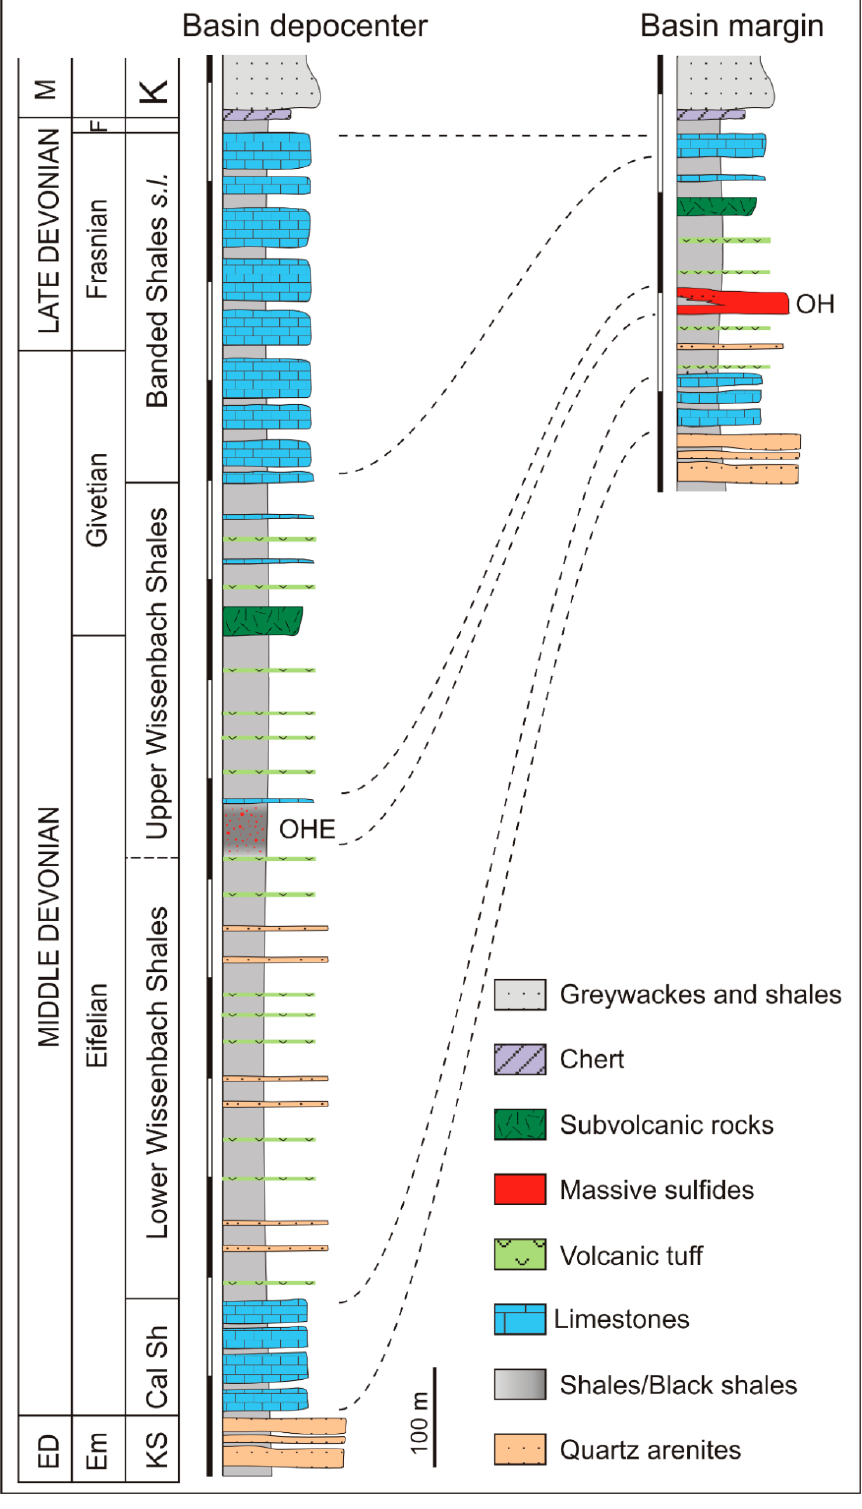
Figure 3. Correlation between the stratigraphic logs at the basin depocenter and basin margin. Abbreviations: KS, Kahleberg sandstones; Cal Sh, Calceola Shales; OH, Ore horizon; OHE, Ore horizon equivalent; K, Culm-related deposits; Em, Emsian; F, Famennian; ED, Early Devonian; M, Mississippian. Data based on Buchholz and Luppold [40], Hannak [41], Sperling [42], Large and Walcher [39], and Abt